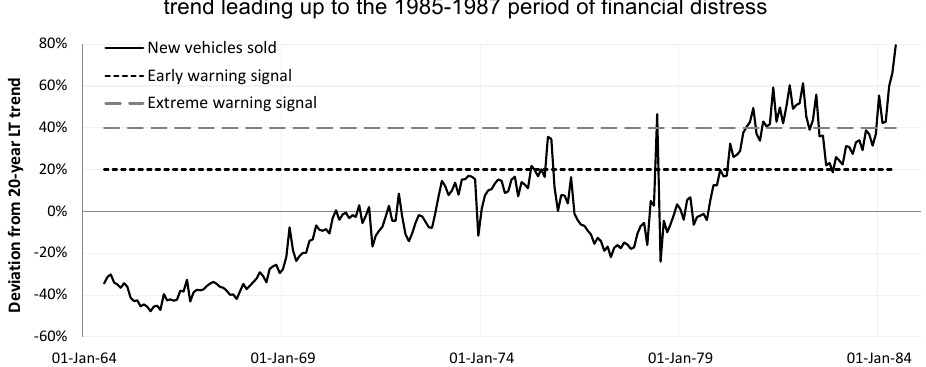
Deviation of the number vehicles sold from its 20-year long-term trend leading up to the 1985-1987 period of financial